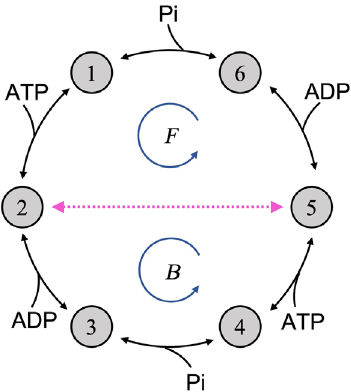
FIG. 10. Sketch of the chemomechanical network model used to describe kinesin motion. The only visible transitions 2 ↔ 5 are marked in dotted magenta. Here, F and B denote the cycle corresponding to the forward and backward movement of kinesin,